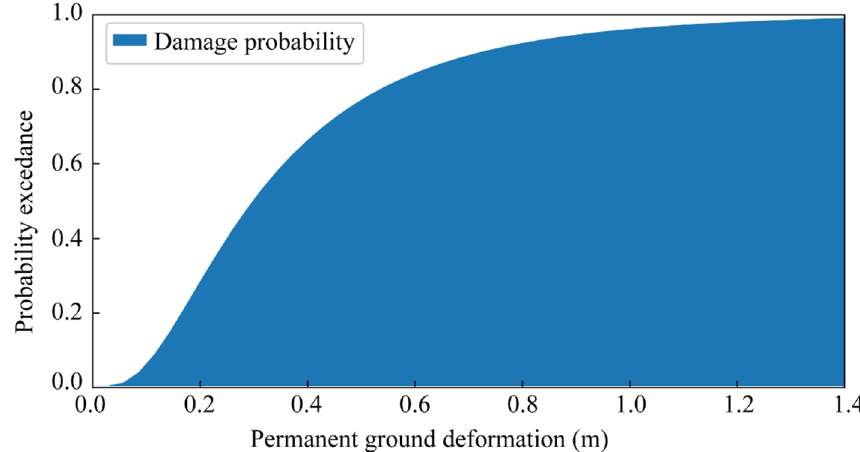
Fig. 5 Seismic fragility curve of a pavement at moderate damage state